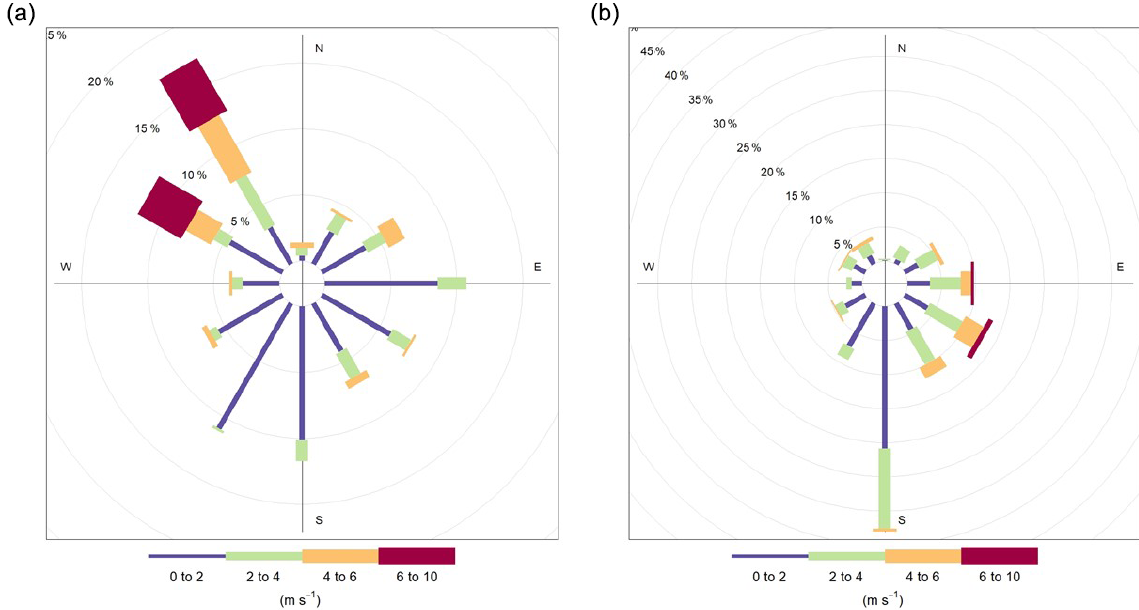
Figure 2. Wind conditions during the winter campaign (a) and summer campaign (b) . The plots show the percentage of time the wind was coming from each direction and are coloured by wind